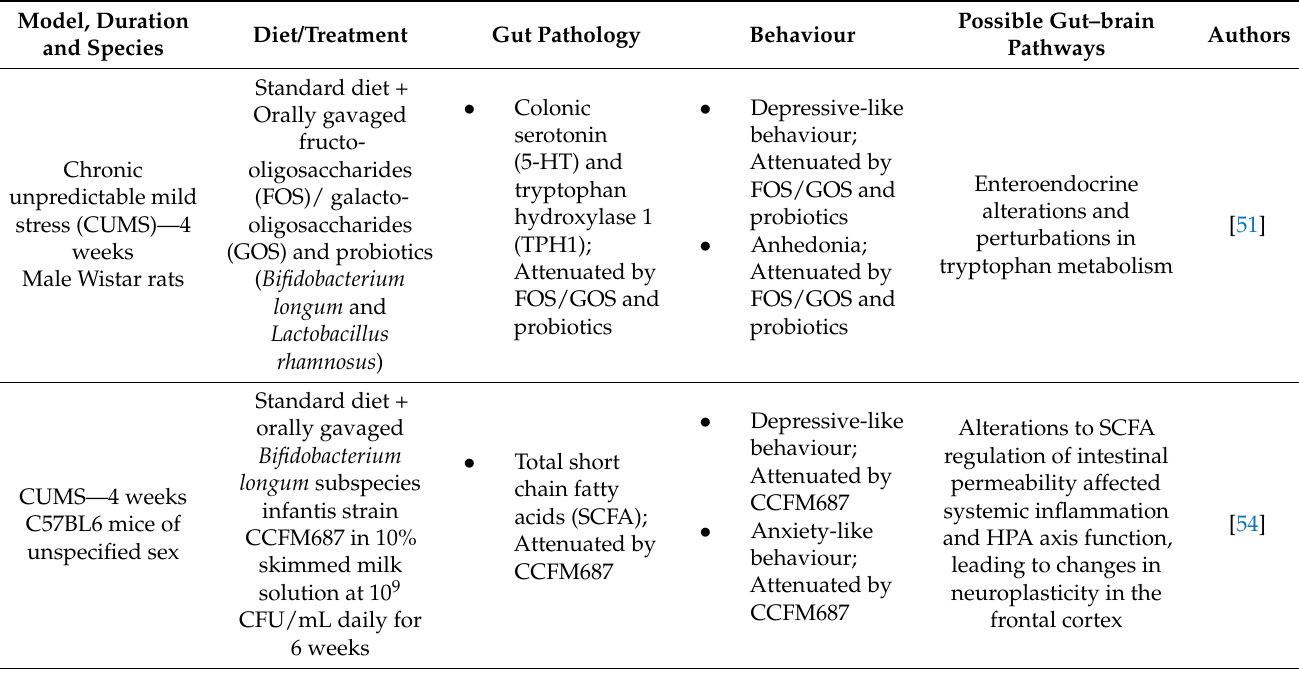
Table 3. The effects of diet on gut pathology, behaviour and potential mechanisms for the brain in animal models of stress and